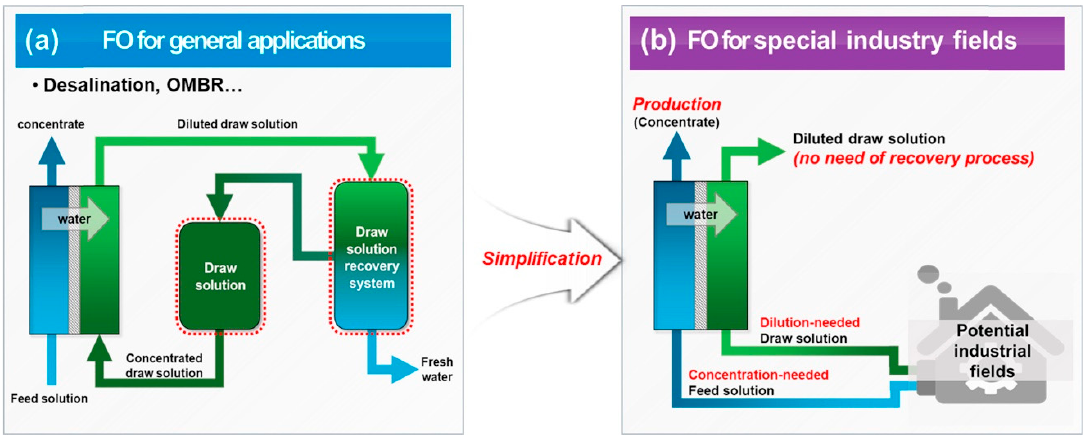
Figure 3. ( a ) FO application for general application with a need for draw solutes recovery; ( b ) FO for special industry fields without the need for a recovery process [56] .